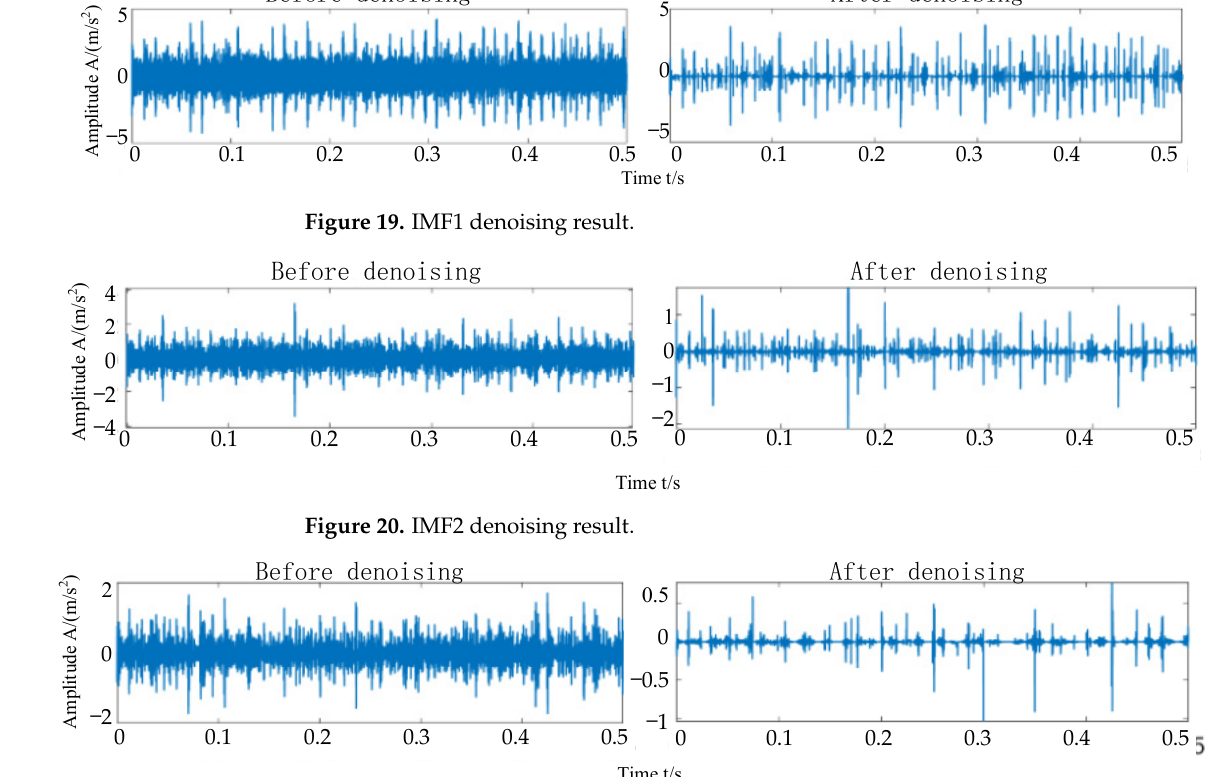
Figure 21. IMF3 denoising result.